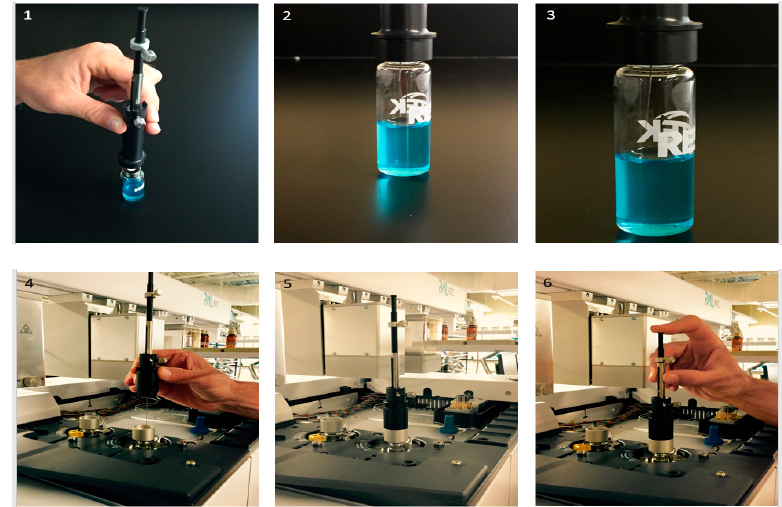
Figure 3. SPME (Arrow and traditional fiber) workflow for gas chromatography (GC) analysis. Manual SPME extraction ( 1 – 3 ) and injection ( 4 – 6 ). ( 1 ) Load SPME in manual syringe and extraction holder and position over sample vial. ( 2 ) Penetrate sample vial septum. ( 3 ) Press down on manual